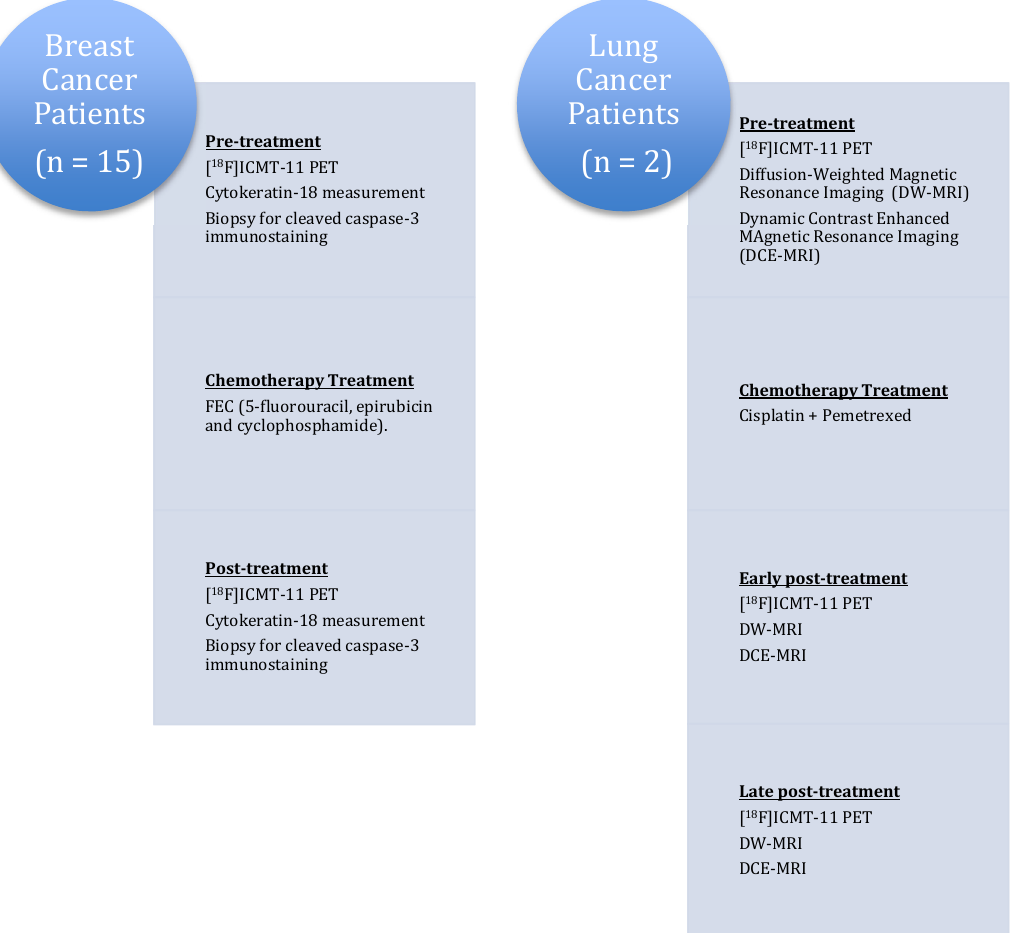
Figure 6. Clinical study design to evaluate the effect of chemotherapy on [ 18 F]ICMT ‐ 11 uptake.